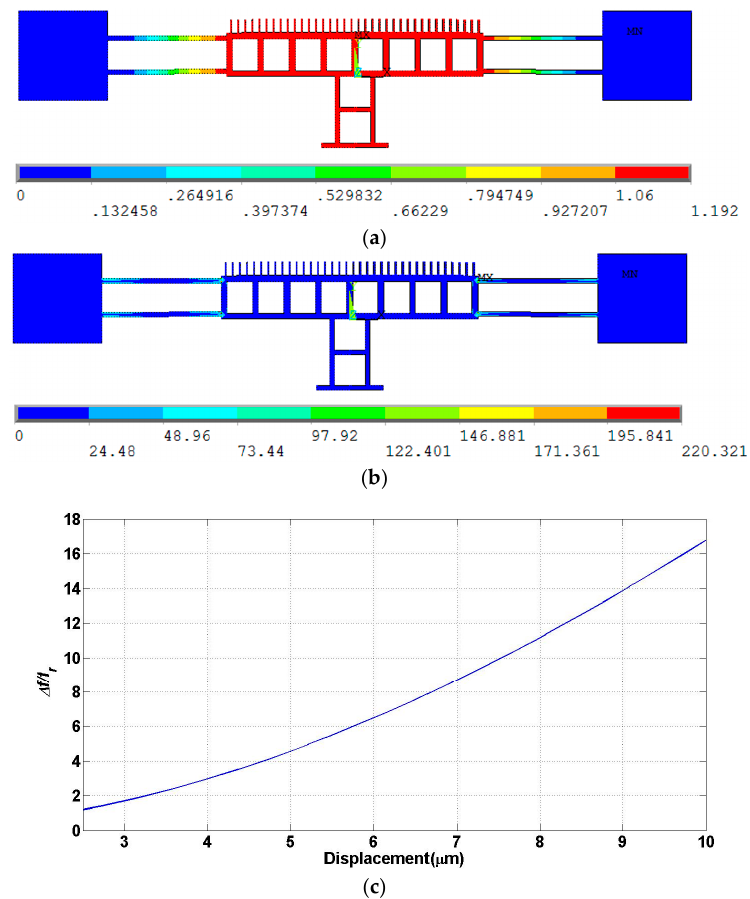
Figure 4. FEA of design B: ( a ) Actuator displacement in μ m; ( b ) Stress profile in μ N/ μ m 2 and ( c ) Resonant frequency shift percentage, percentage of difference in frequency divided by resonance frequency f r , versus displacement.